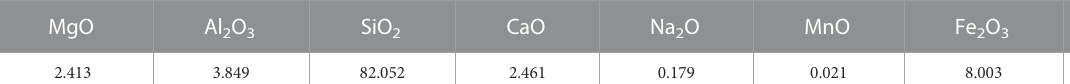
TABLE 1 Chemical constituents of the whole tailings (%).